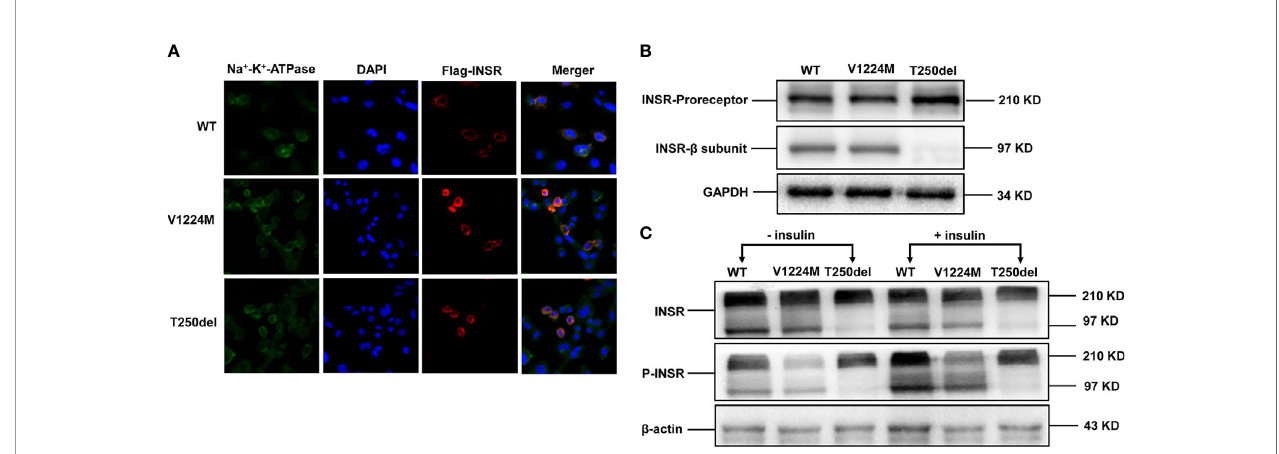
FIGURE 2 | Expression and processing of wild-type (WT) and mutant INSRs in Chinese hamster ovary (CHO) cells. (A) Immuno fl uorescence of CHO cells transiently transfected with the indicated FLAG-tagged INSR, WT or mutant vectors (p.V1224M and p.T250del). (B) Western blot analysis of the INSR proreceptor (210 kD) and the mature b -submit of the INSR (97 kD). (C) Insulin-stimulated phosphorylation of INSR and western blot analysis of INSR phosphorylation. DAPI, 4 ’ ,6-diamidino-2- phenylindole.